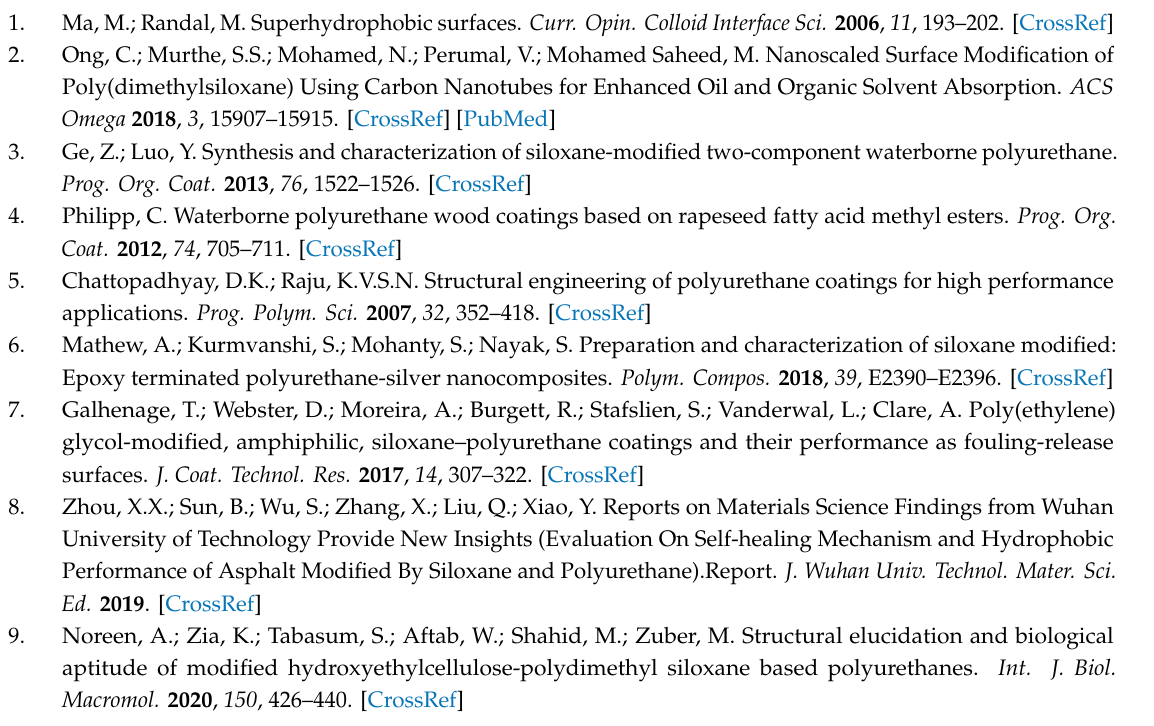
Figure S1: Synthesis of prepolymer and fluoro-polyurethane, Figure S2. Waterdrops rolled on Cu2 +/ HNO3-etched zinc + fluoropolyurethane (rolling angle 8 ± 1.6 ◦ ), Table S1. Uncertainty / error and parameters of non-standard design